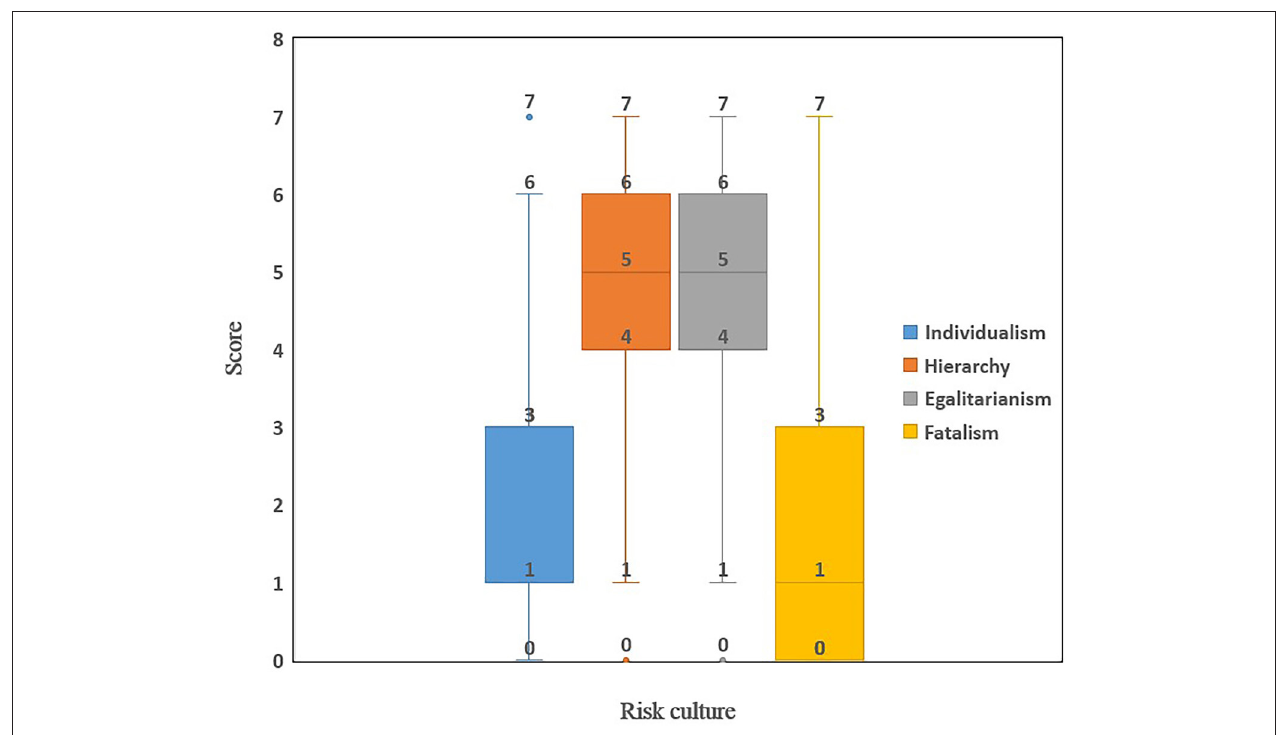
FIGURE 2 | Status quo of culture type.